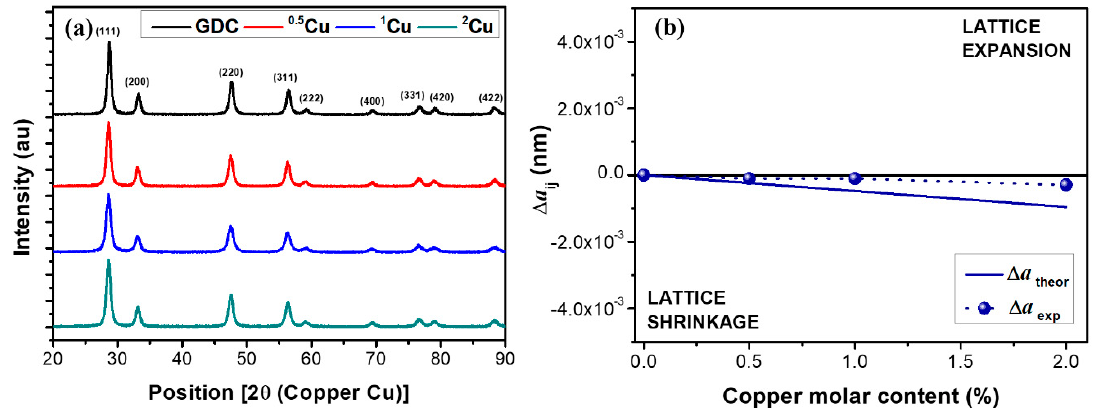
Figure 1. XRD spectra for ( a ) Cu-doped GDC powders and ( b ) Vegard model